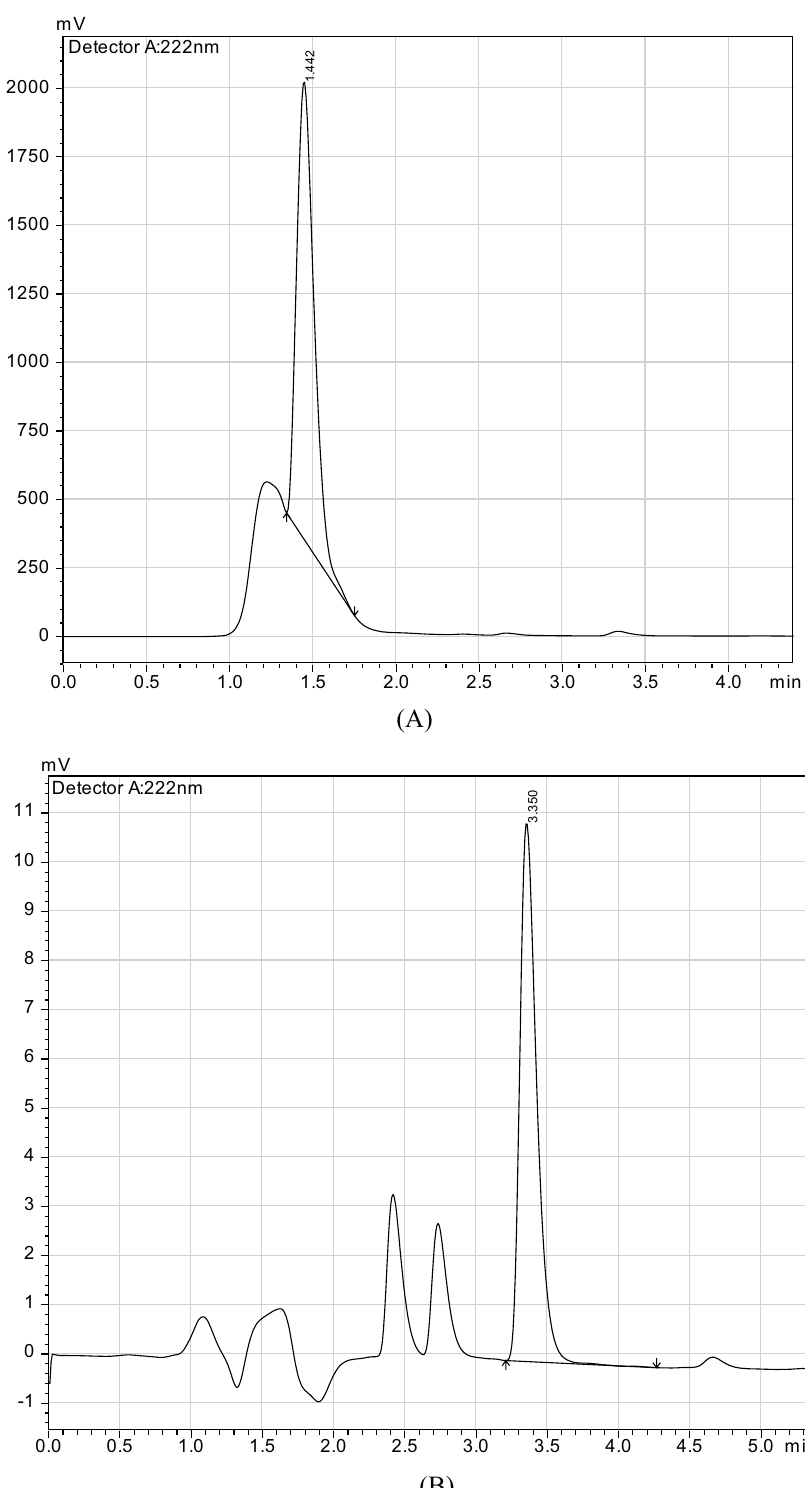
Fig. 1 Representative peaks of A Blank plasma; B Metoprolol Succinate (4 μg/mL); C Plasma